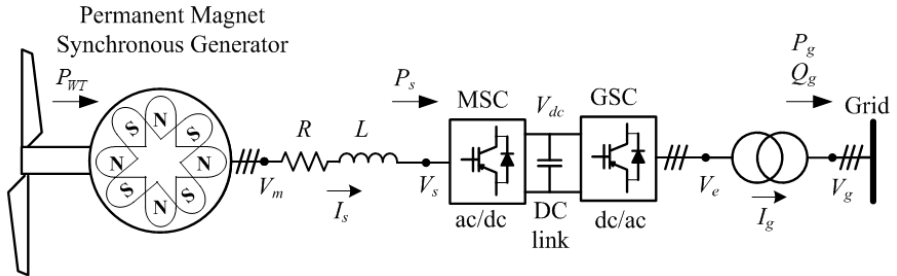
Figure 1. Direct drive synchronous generator (DDSG) wind turbine layout. MSC: machine side converter; and GSC: grid side converter.